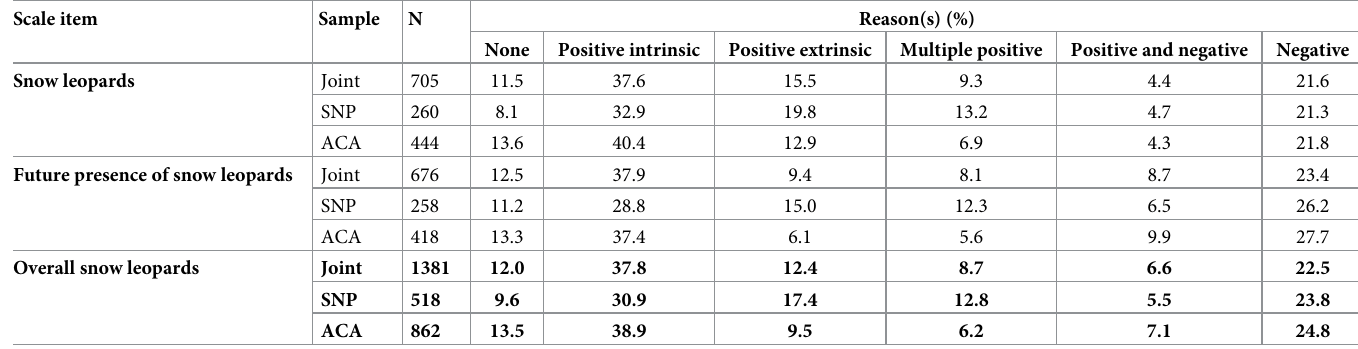
Table 2. Reasons for attitudes to snow leopards for a combined sample, in Sagarmatha National Park (SNP) and Annapurna Conservation Area